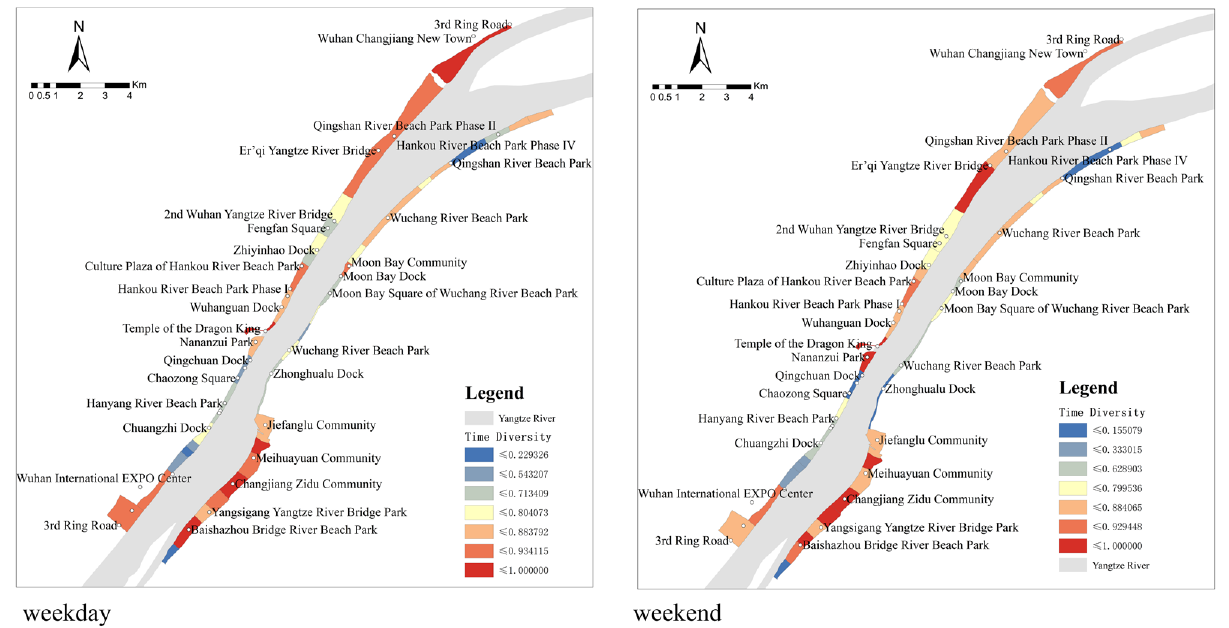
Figure 9. The time diversity distribution of the riverside area of Wuhan. This part analyzes the spatiotemporal attractiveness characteristics of the riverside area of Wuhan from the spatial and temporal dimensions. The specific findings are as